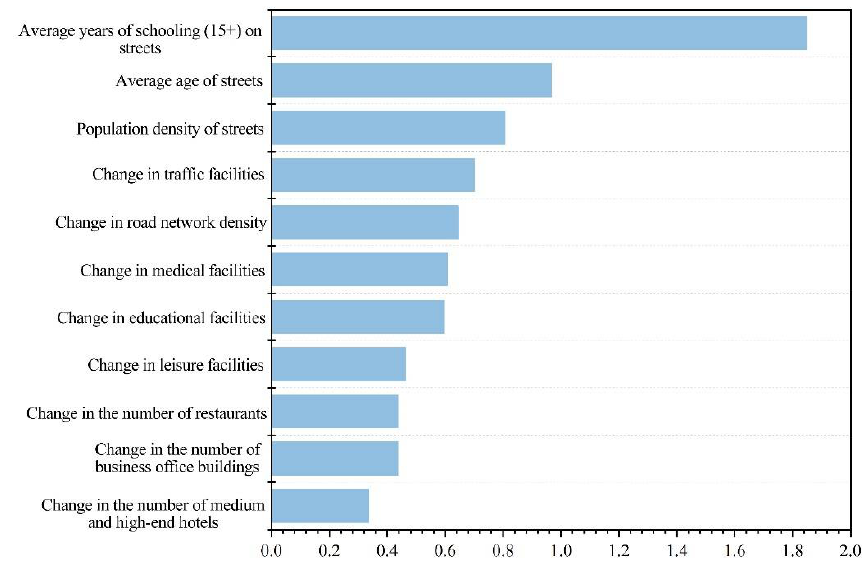
Figure 5. Results for the Gini impurity (importance of indicator).